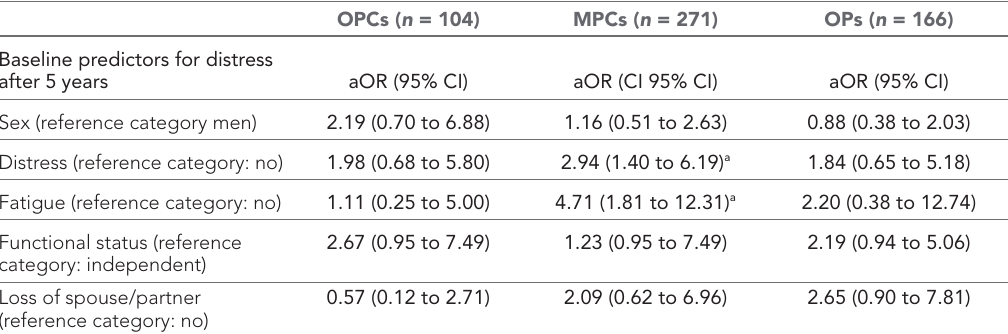
Table 2 Multivariable logistic regression model with predictors for distress after 5 years, per patient